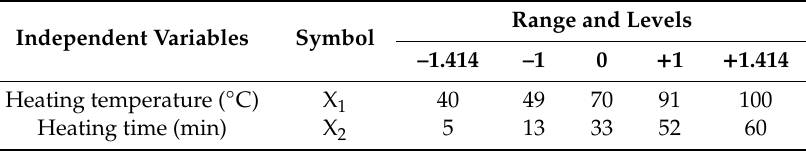
Table 1. Experimental range and values of independent variables in the central composite design for monitoring the e ff ects of thermal treatment on the physical properties of CAG